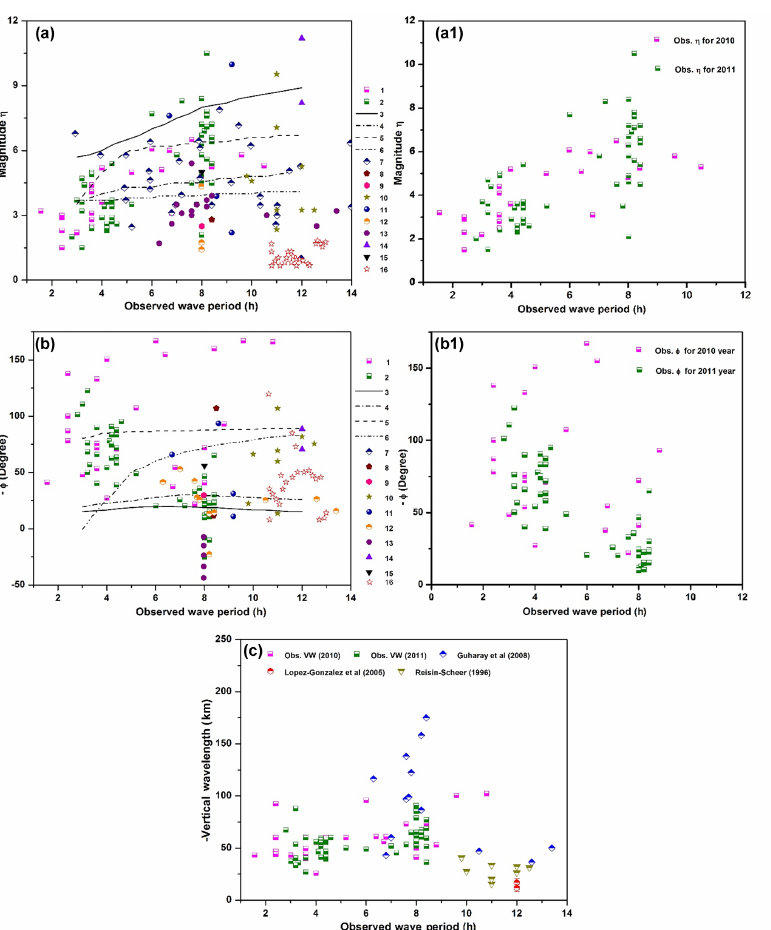
Figure 2. (a) Distribution of Krassovsky parameter “ η ”, reported by investigators (list not exhaustive). The x axis shows the wave periodicity and the y axis is for amplitude of Krassovsky parameters ( η ). The legends in the figure are as follows: (1) (for year 2010) and (2) (for year 2011) – present study; (3) Schubert et al. 500km; (4) Schubert et al. 1000km; (5) Tarasick and Shepherd 500km; (6) Tarasick and Shepherd 1000km; (7) Takahashi et al. (1992); (8) Oznovich et al. (1995); (9) Drob et al. (1996); (10) Reisin and Scheer (1996); (11) Taylor et al. (2001); (12) Guharay et al. (2008); (13) Walterscheid and Schubert (1995); (14) Lopez-Gonzalez et al. (2005); (15) Oznovich et al. (1997); and (16) Viereck and Deehr (1989). (a1) Observed values of η versus wave period over Kolhapur alone. (b) Distribution of phase values of Krassovsky parameter “ (cid:56) ”, reported by investigators (list not exhaustive) (1) (for year 2010) and (2) (for year 2011) – present study; (3) Schubert et al. 500km; (4) Schubert et al. 1000km; (5) Tarasick and Shepherd 500km; (6) Tarasick and Shepherd 1000km; (7) Viereck and Deehr (1989); (8) Oznovich et al. (1995); (9) Drob et al. (1996); (10) Reisin and Scheer (1996); (11) Taylor et al. (2001); (12) Guharay et al. (2008); (13) Walterscheid and Schubert (1995); (14) Lopez-Gonzalez et al. (2005); (15) Oznovich et al. (1997); and (16) Viereck and Deehr (1989). (b1) Observed values of (cid:56) verses wave period over Kolhapur alone. (c) Deduced vertical wavelength (VW) for both the short- and long-period wave as a function of wave periodicity compared to other published